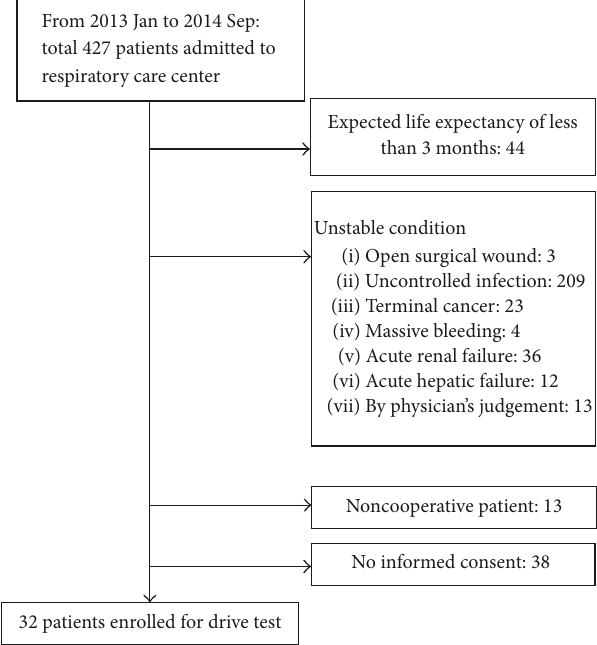
Figure 1: Diagram of enrolled patients with hypercapnic ventilatory response in respiratory care